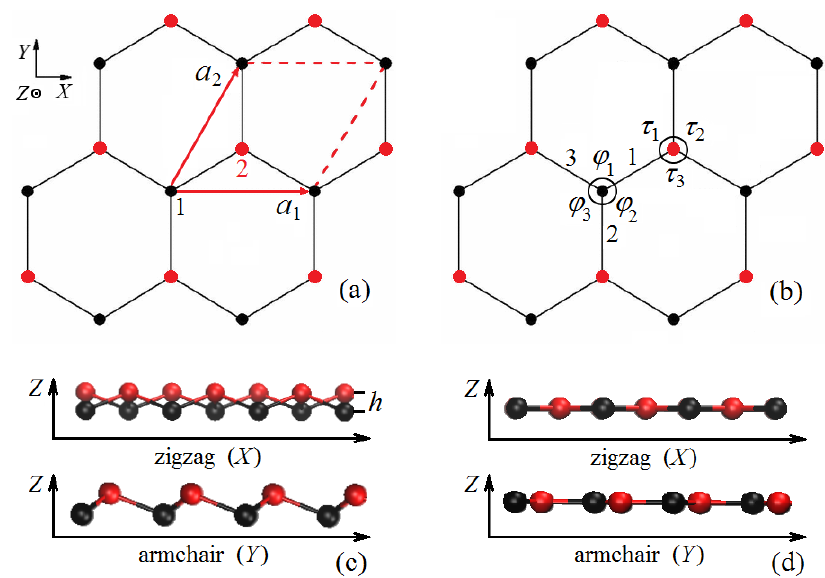
Figure 1. ( a ) The structure of the stanene shown in projection onto the XY plane with the X and Y axes oriented in the zigzag and armchair directions, respectively. A primitive translational cell containing two Sn atoms is defined by the translation vectors a 1 and a 2 . The atoms of the two sublattices are colored black and red and can have different Z -coordinates. ( b ) Valence bonds and angles that will be analyzed when the stanene is deformed. Panels ( c ) and ( d ) show the stanene projected onto the XZ and YZ planes for the buckled structure having thickness h and absolutely flat structure,